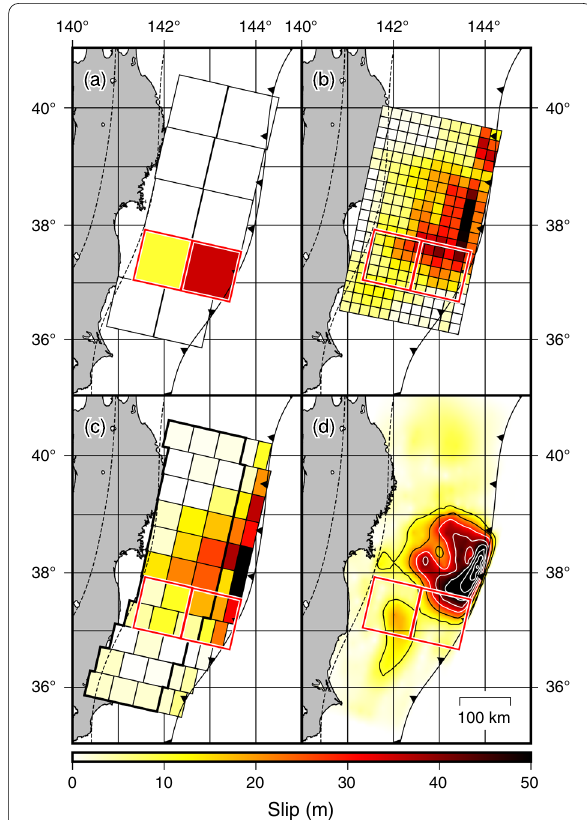
Fig. 11 Slip distribution models of the 2011 Tohoku-oki earthquake. Red frames represent the projected shapes of subfaults S4 and